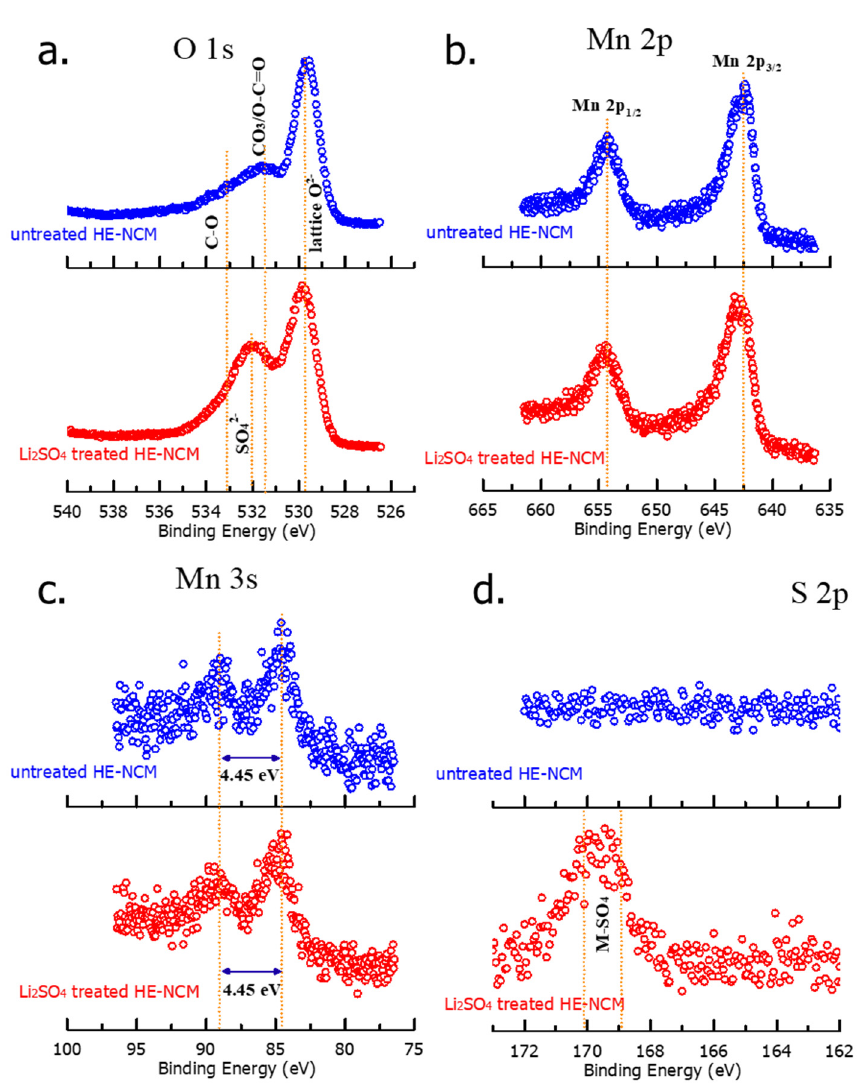
Figure 5. XPS spectra of O 1s ( a ), Mn 2p ( b ), Mn 3s ( c ), and S 2p ( d ) measured from untreated and Li 2 SO 4 treated HE-NCM cathode materials.